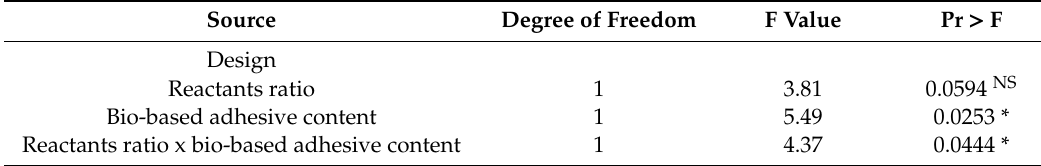
Table 4. E ff ect of parameters in the thermal conductivity ( λ ) of insulation boards. Table 4. Effect of parameters in the thermal conductivity ( λ ) of insulation boards. Source Degree of Freedom F Value Pr > F Source Degree of Freedom F Value Pr > F Design